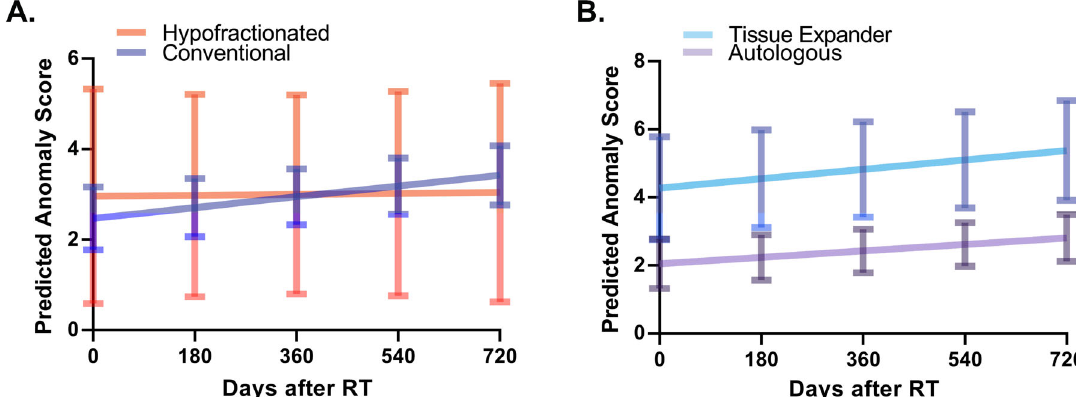
Fig. 4 Change of AS according to RT fractionation and reconstruction type in time-dependent manner. Comparison of predicted anomaly score generated by linear mixed effect model between patients receiving hypofractionated and those receiving conventional fractionation of RT ( A ) and between patients reconstructed with tissue expander and those with autologous tissue ( B ). The 95% con fi dence intervals are drawn as error bars at each point. RT Radiation